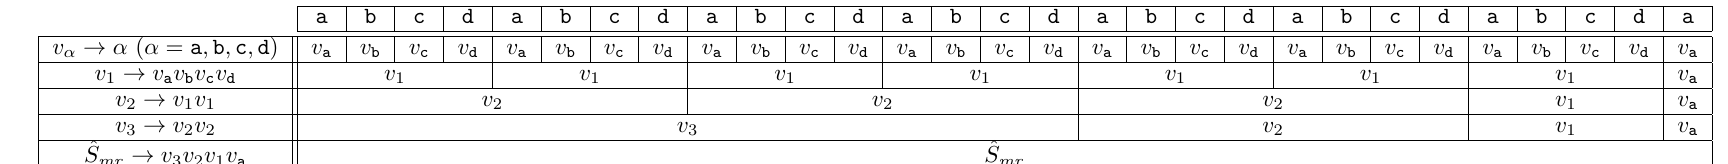
Figure A3. Grammar generation process of MR-RePair and its generated grammar for the text ( abcd ) 7 a . The grammar size is